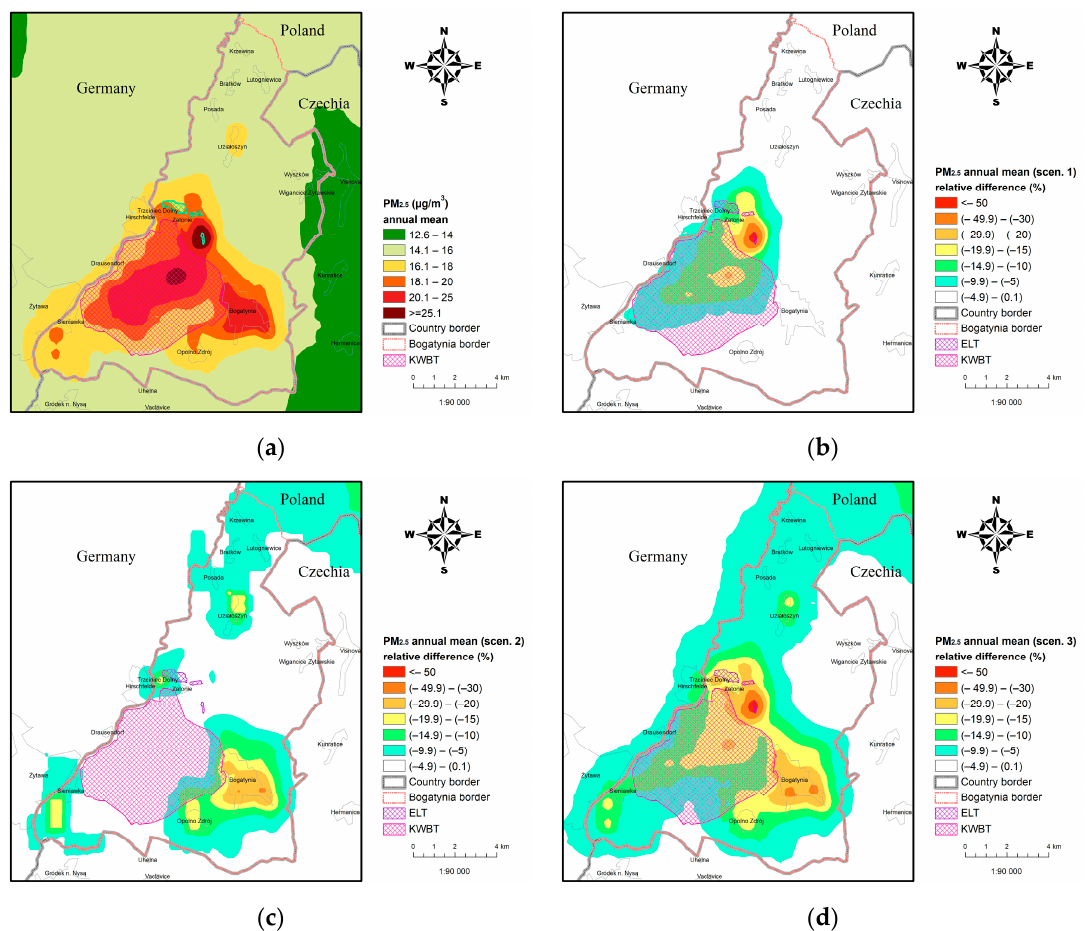
Figure 21. PM 2.5 annual mean concentrations in 2018: modeled values and relative differences for the analyzed scenarios (source: own study): ( a ) in 2018, ( b ) relative difference for scenario 1, ( c ) relative difference for scenario 2, ( d ) relative difference for scenario 3.